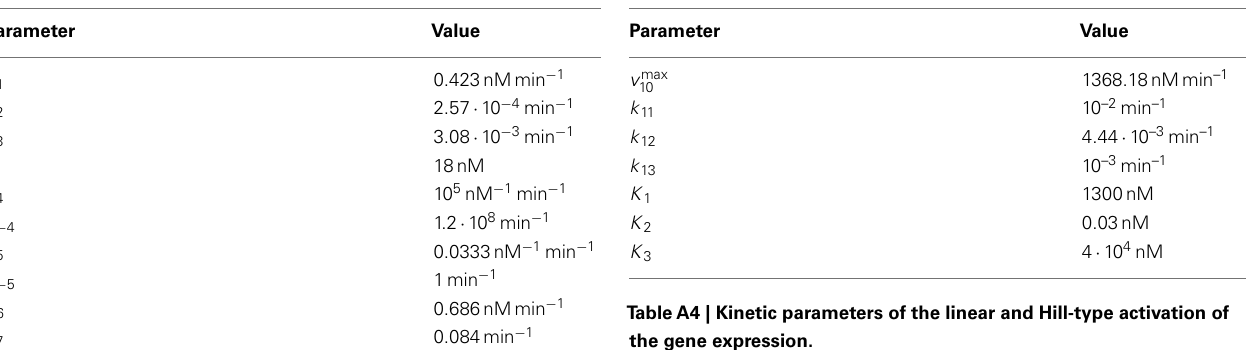
TableA1 | Kinetic parameters of the signal transduction module.